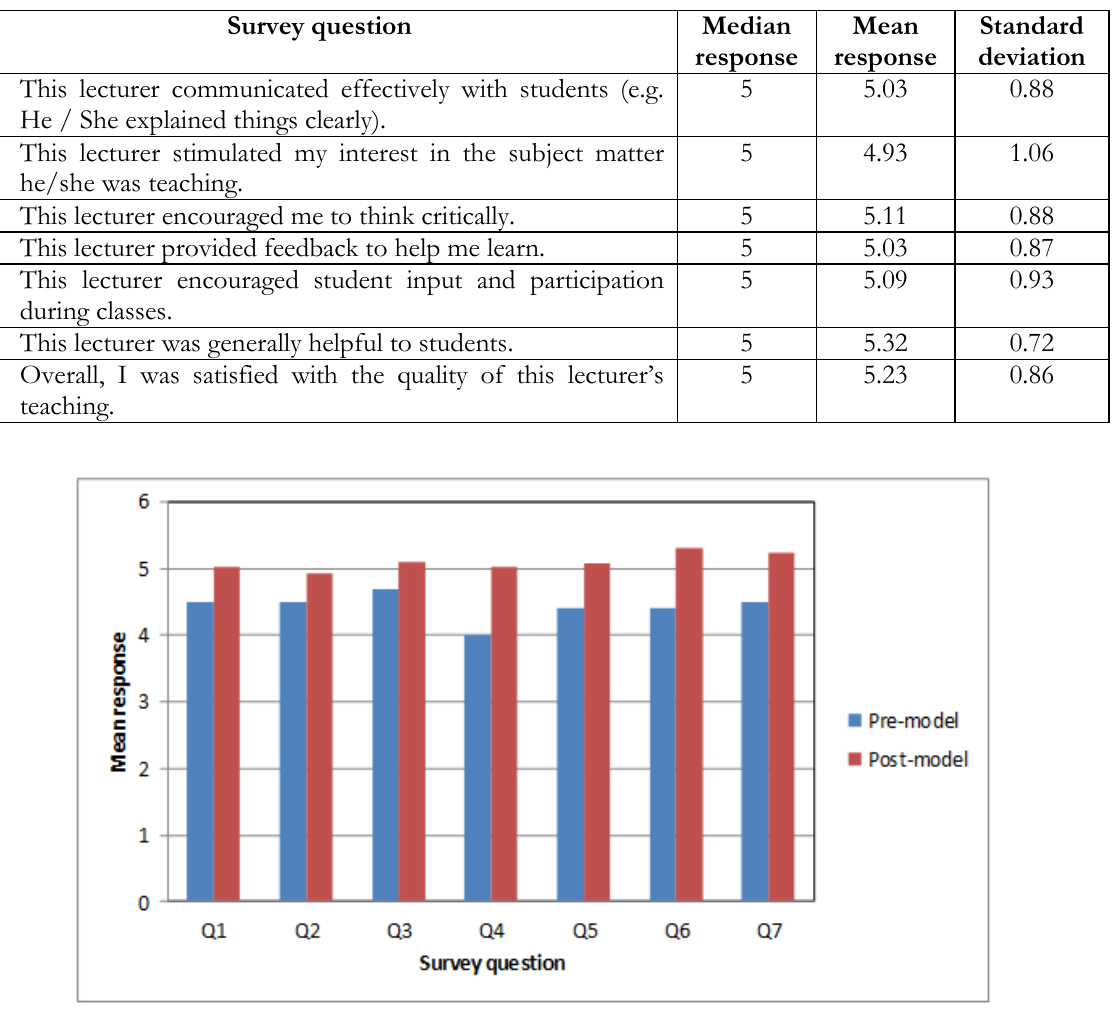
Figure 3: Comparison of pre and post model implementation outcomes